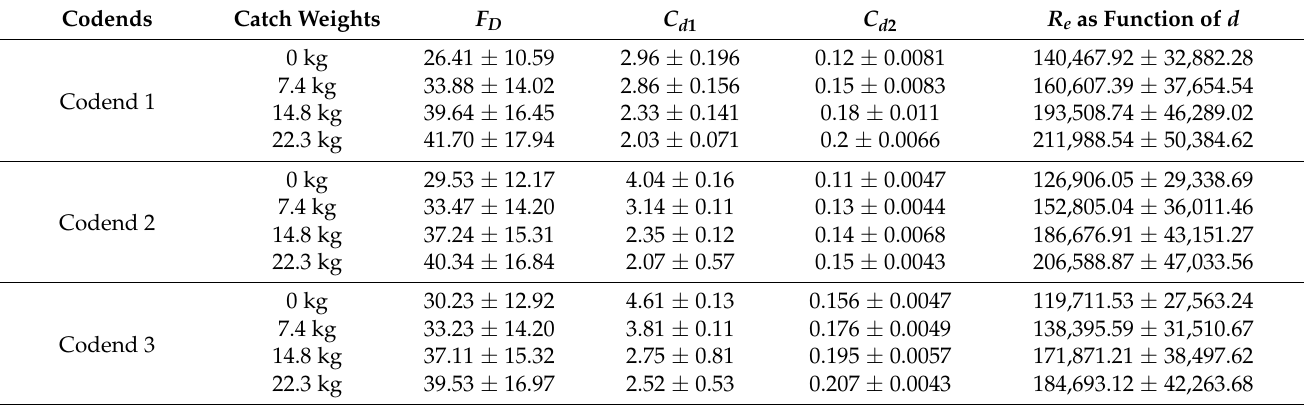
Figure 7. Drag force of the three codends at different catch weight as function of flow velocity. Table 3. Summary statistics results of the hydrodynamic performance parameters for the three codends (the mean values with the standard deviation); current data estimated with 95% confidence intervals from the GLMM.